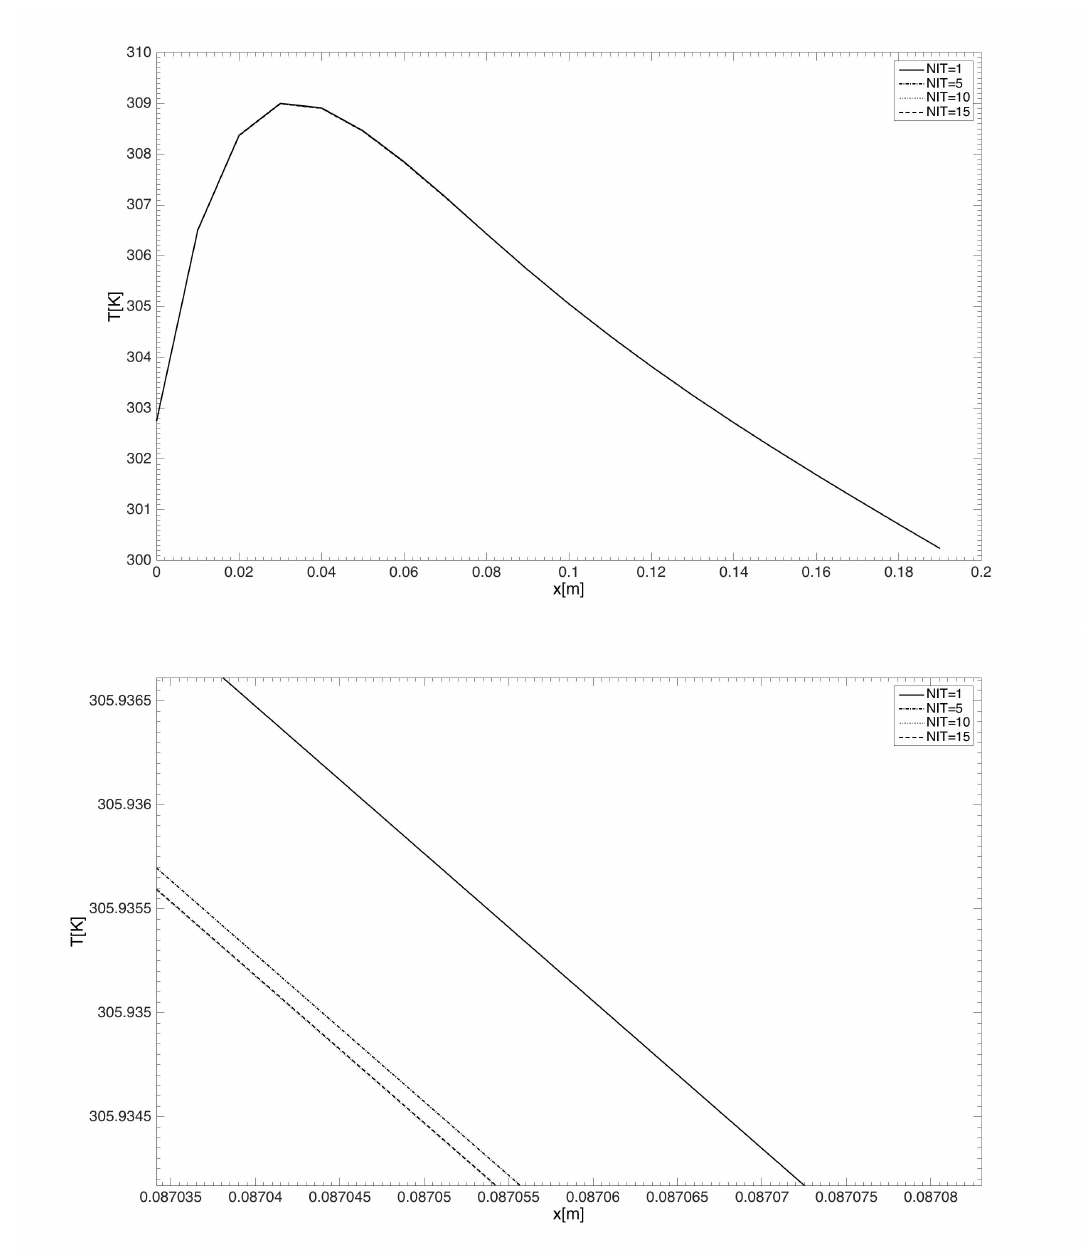
Figure 6. Temperature profiles at y = 0.04 m against x -axis for different number of iterations. The lower graph is scaled